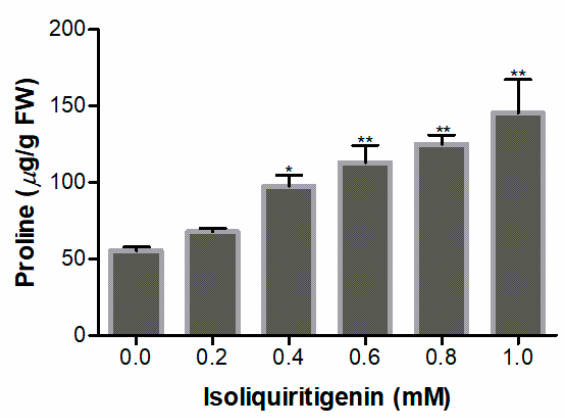
Figure 9. Proline content in lettuce seedlings after treatment with different concentrations of isoliquiritigenin. Data presented are the mean ± standard deviation of results from three independent experiments. N = 3. One asterisk * and two asterisks ** represent the significant difference between the isoliquiritigenin-treated lettuce seedlings and the control at p < 0.05 and p < 0.01, respectively.